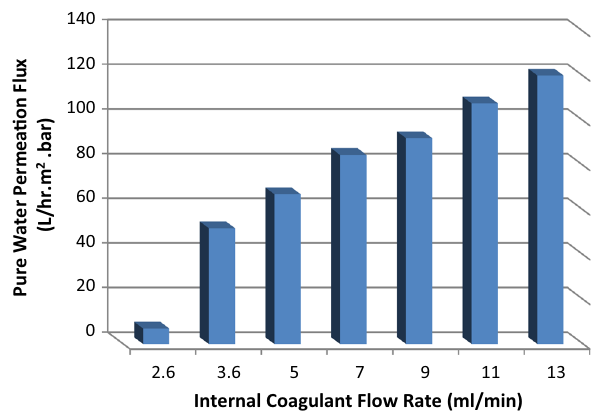
Fig. 10 Effect of various ICFR on pure water permeation flux of the fibers